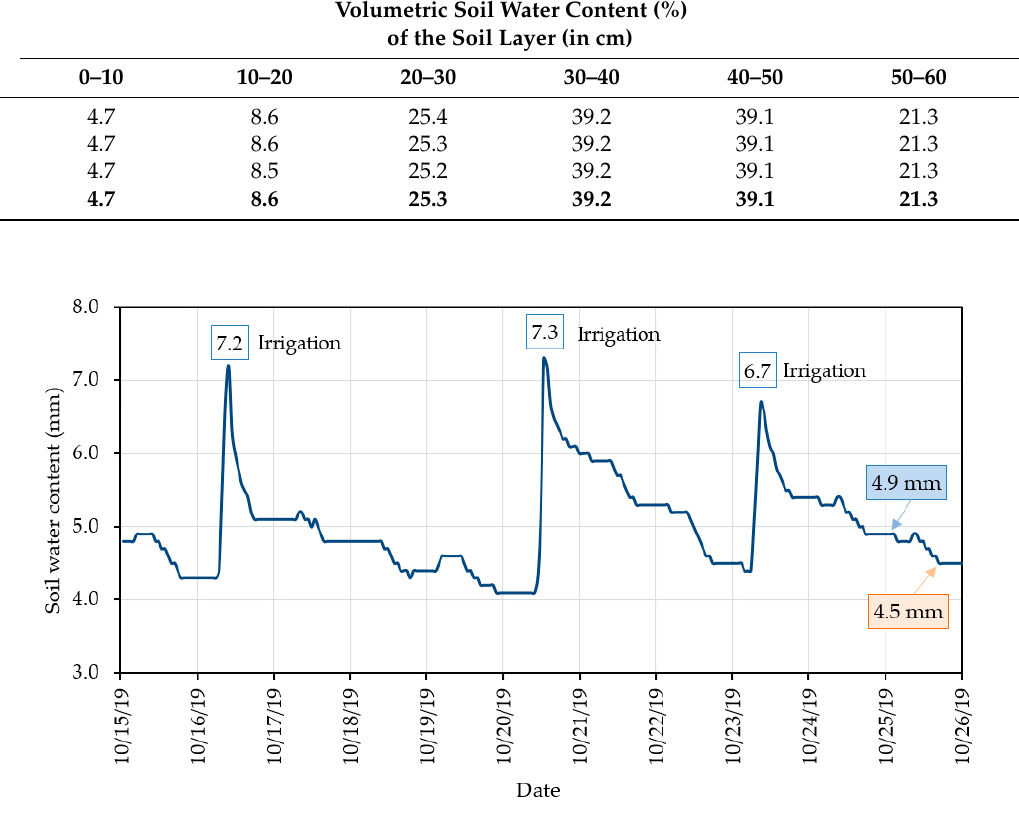
Figure 16. The fluctuation of the soil moisture in the surface layer of the soil (0–10 cm) after three consecutive irrigations.